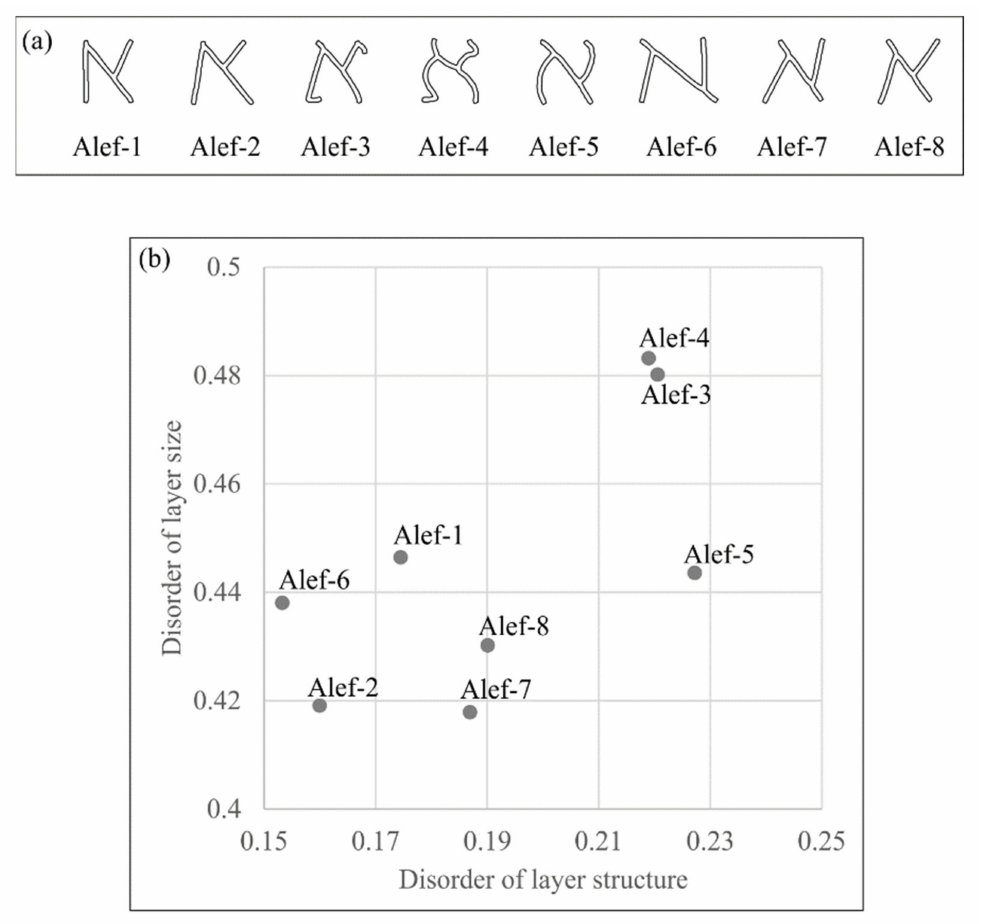
Figure 18. Evolution of the shape of the letter Alef in historical texts. ( a ) Various forms of Alef. ( b ) Mutual arrangement of Alef in 2-D morphological space. Credit: Drawing by Dr. Ada Yardeni, courtesy of Carta Jerusalem